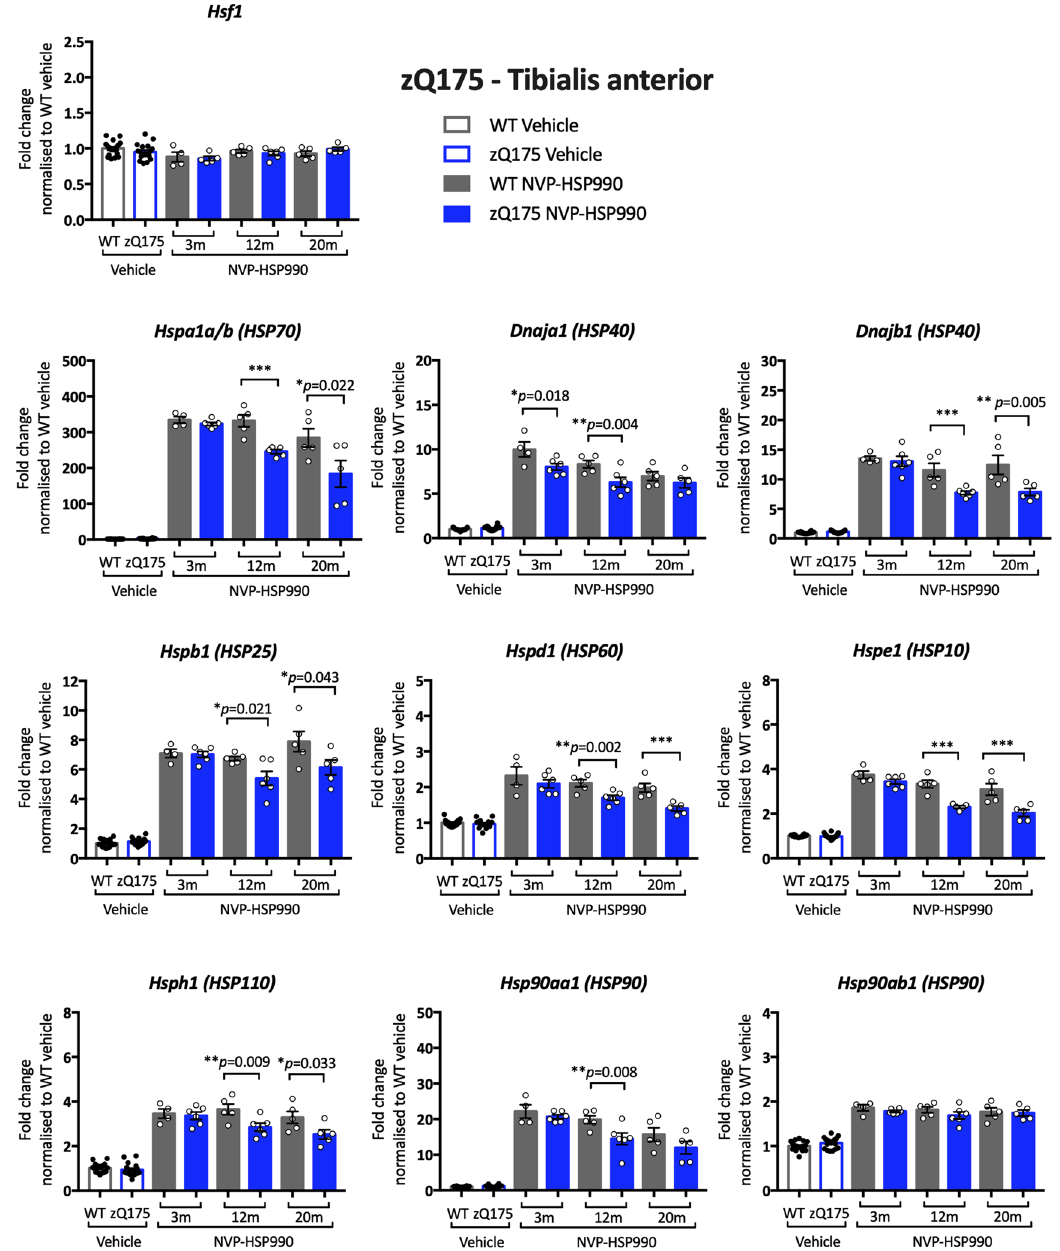
Figure 3. Analysis of the heat shock response in the tibialis anterior of zQ175 mice with disease progression. The expression of heat shock genes was measured using the QuantiGene 16-plex assay in the tibialis anterior of wild-type and zQ175 mice at 3, 12 and 20 months of age that had been treated with vehicle or NVP-HSP990. The NVP-HSP990 treated samples were normalised to the corresponding age-matched wild-type vehicle treated samples. For simplicity, the wild-type vehicle samples and the zQ175 vehicle samples from the three ages were combined. Five NVP-HSP990 treated samples were excluded from the analysis, because the tibialis anterior heat shock gene expression levels were comparable to those treated with vehicle. These were: at 3 months, two wild type; at 12 months, one wild-type; at 20 months, one wild-type and one zQ175. N = 4–6/genotype/treatment/age. Statistical analysis was by two-way ANOVA with Bonferroni correction for multiple comparisons. Mean ± SEM. *** p ≤ 0.001. Test statistical values can be found in Supplementary Table S9 online. WT wild-type, m